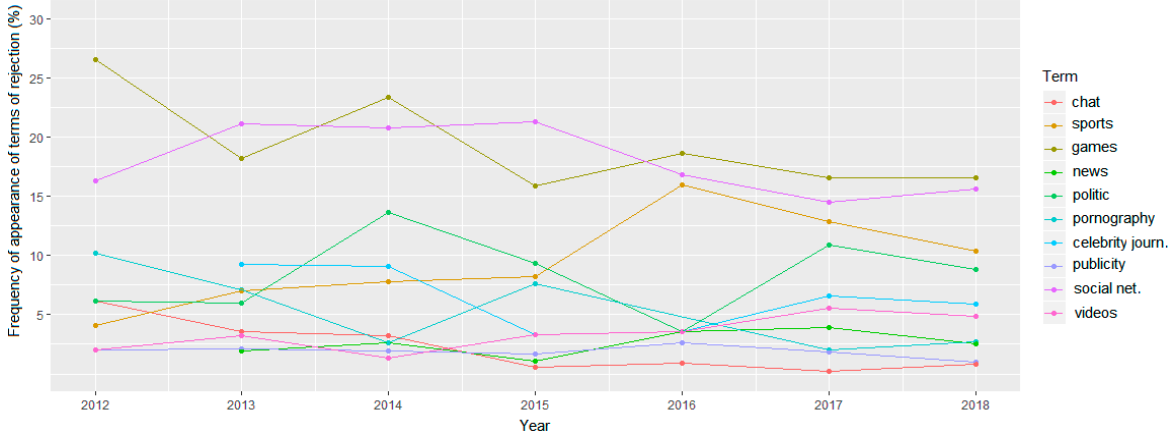
Figure 4. Annual variation of the 10 most common terms named by respondents as topics of rejection for web surfing.